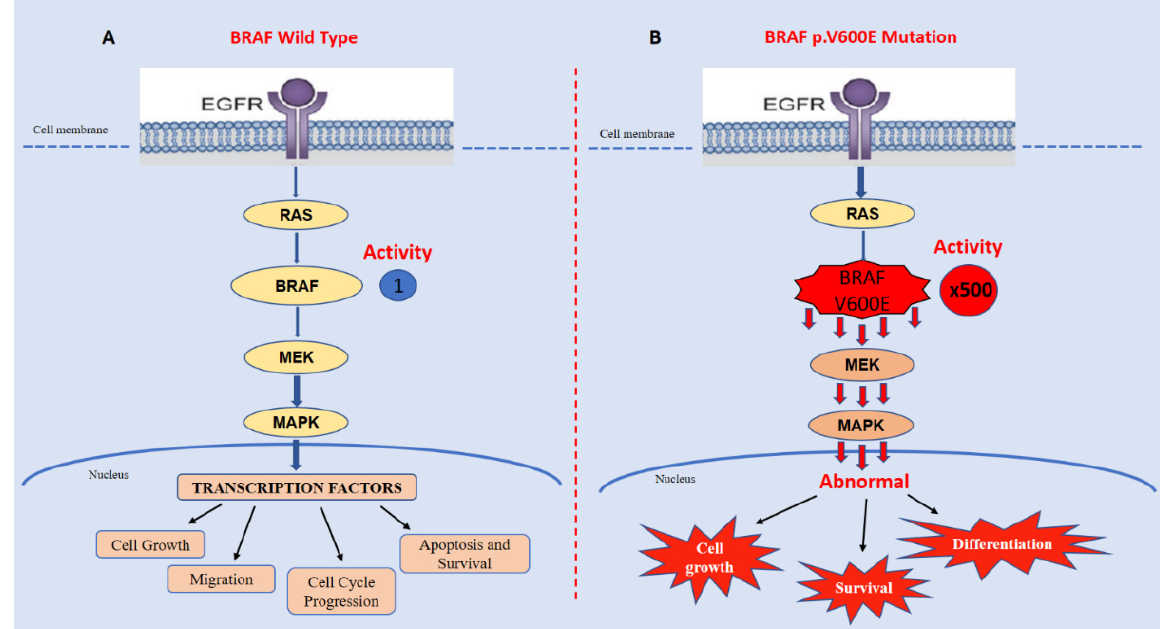
Figure 3. The p.V600E-mutated BRAF has approximately 500-fold greater activity than its wild-type form ( B vs. A ), resulting in excessive MAPK signaling and abnormal cell growth, survival, and dif- ferentiation.